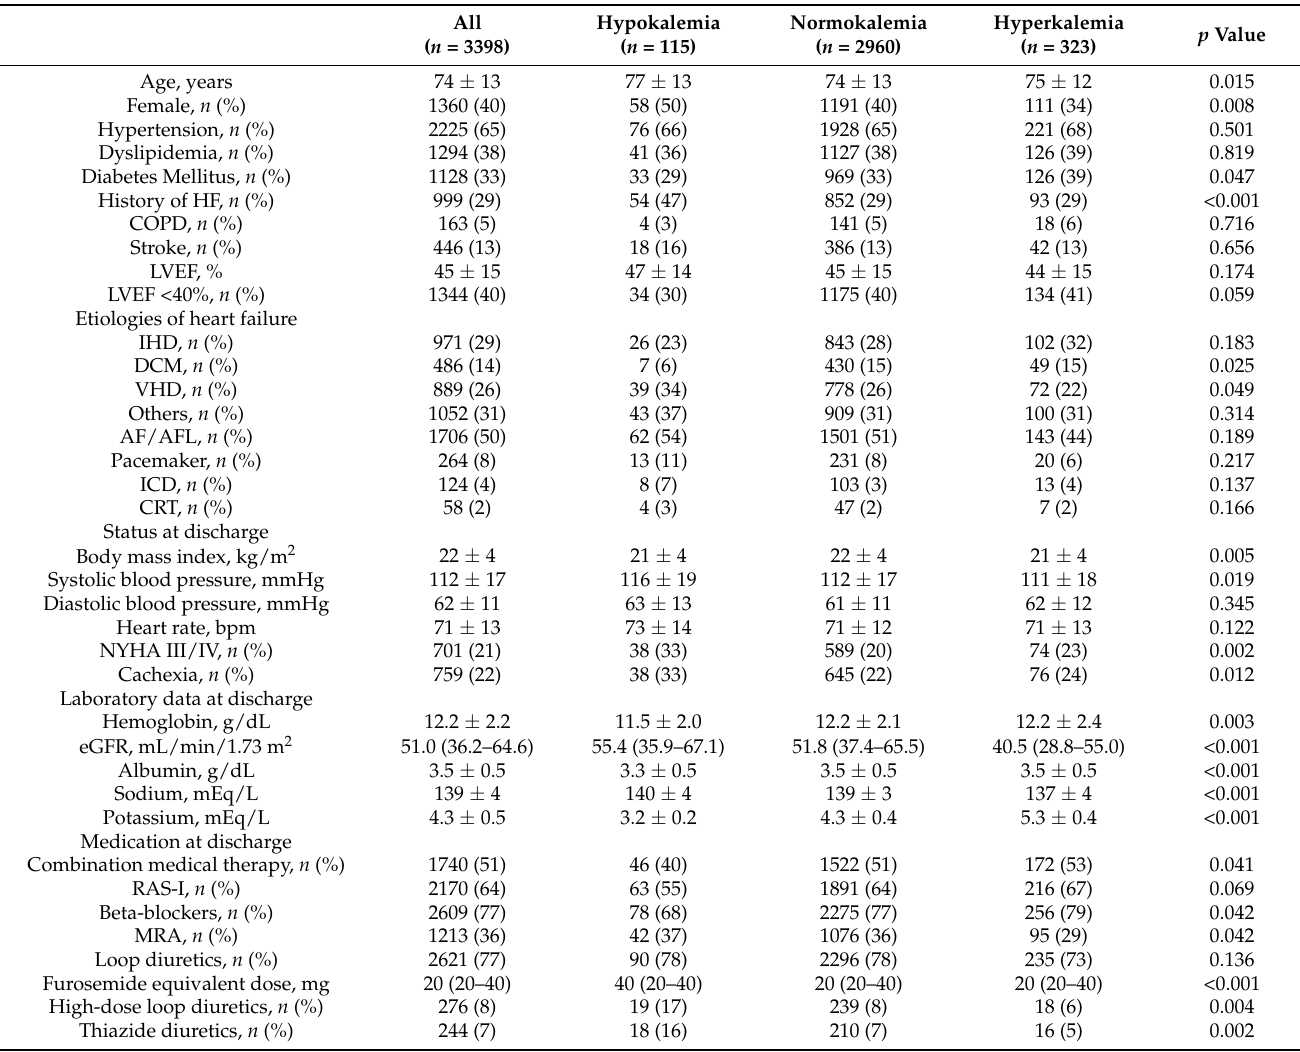
Table 1. Patient